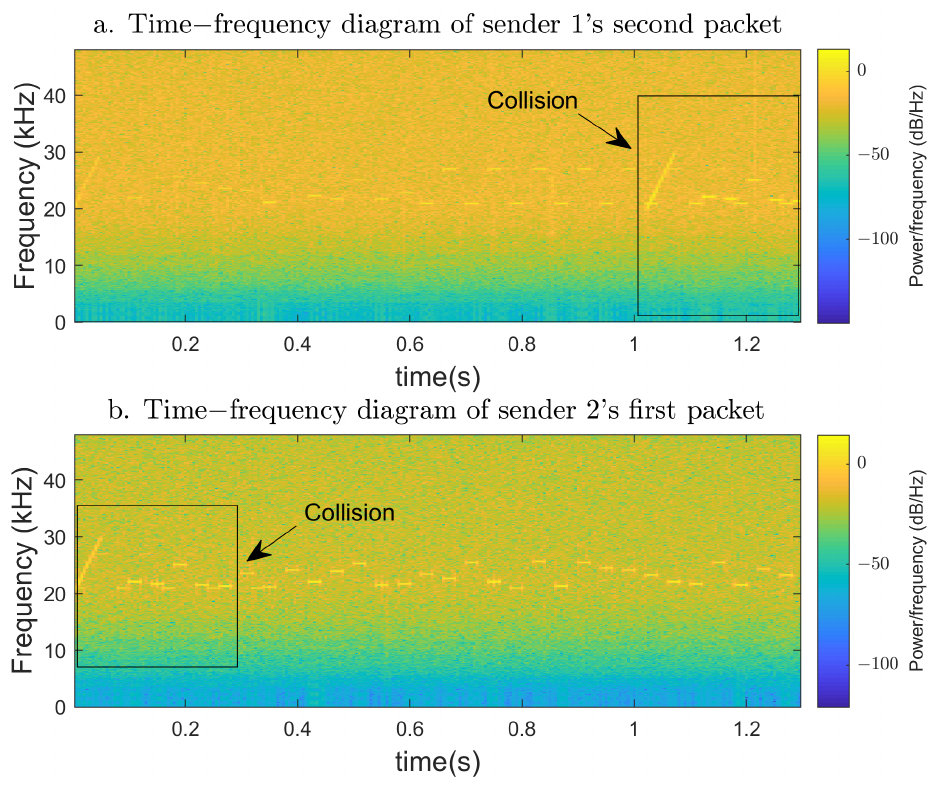
Figure 11. Time–frequency diagram of packets.